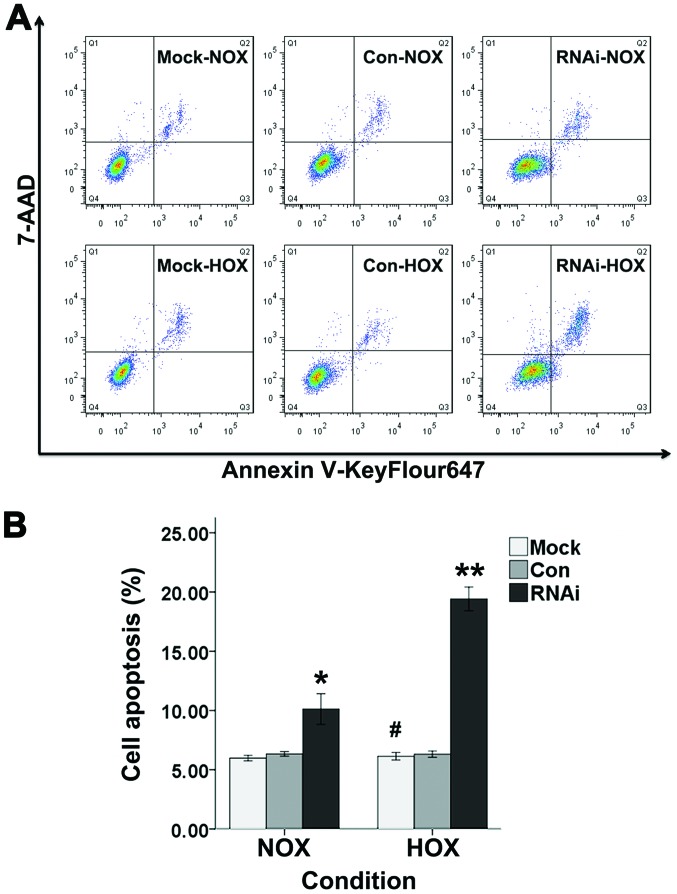
The apoptosis rate of Mock, Con and RNAi cells were evaluated by FACS. (A) The three groups of cells were treated with or without DFO for 24 h. Annexin V-KeyFlour647 and 7-AAD-staining of cells were performed and followed by flow cytometeric analysis. Cells in Q1 quadrant represent cells undergoing necrosis, Q2 quadrant represent late stage of apoptosis, Q3 quadrant represent early stage of apoptosis and Q4 quadrant represent viable cells. (B) The percentage of cell apoptosis for Mock, Con and RNAi cells in normoxia and hypoxia (bars, ± SD, #p>0.05, compared to normoxic Mock cells, *p<0.05, compared to Mock and Con cells in normoxia, **p<0.01, compared to Mock and Con groups in hypoxia). NOX, normoxia; HOX, hypoxia.